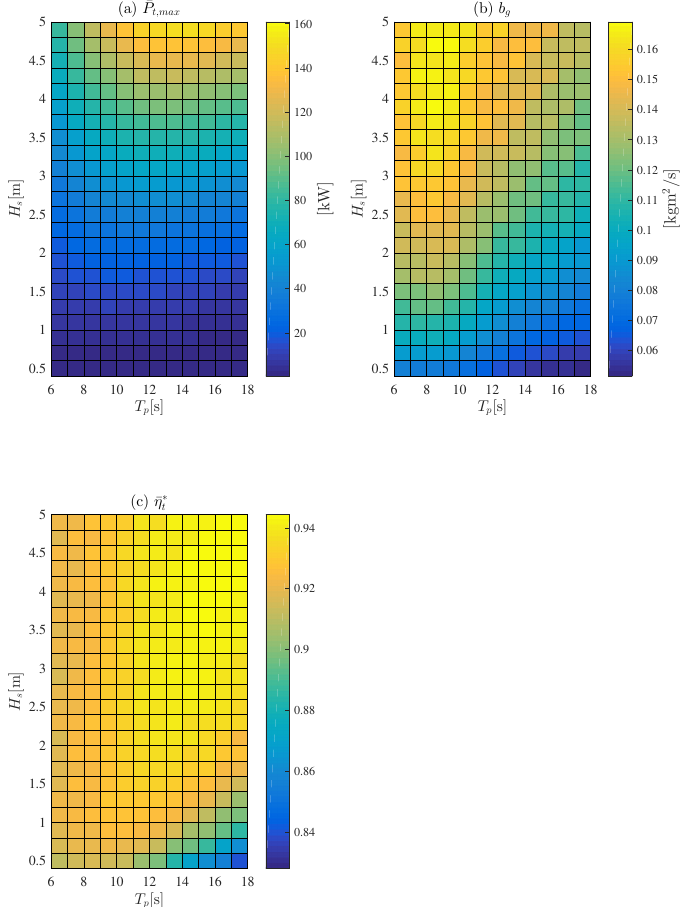
Figure 12. Time averaged results for maximum power extraction with b g fixed in time under the Pierson–Moskowitz (PM) irregular wave model with various T p and H s for T m = 5000 s: ( a ) maximum power extraction from turbine; ( b ) generator damping coefficient; ( c ) relative turbine